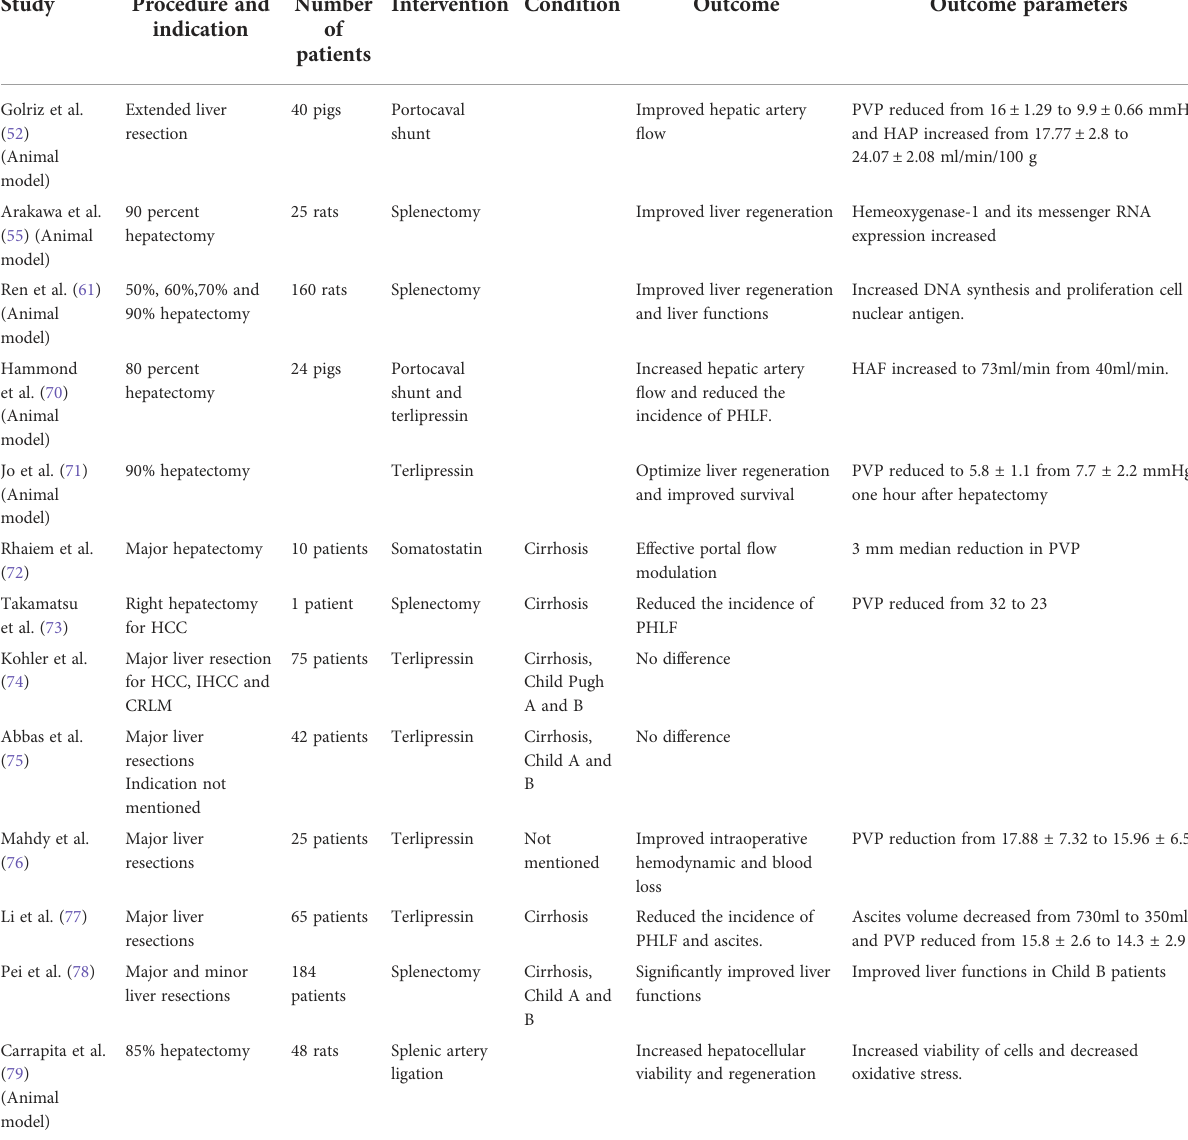
TABLE 1 Studies reporting portal fl ow modulation techniques after liver resection to prevent